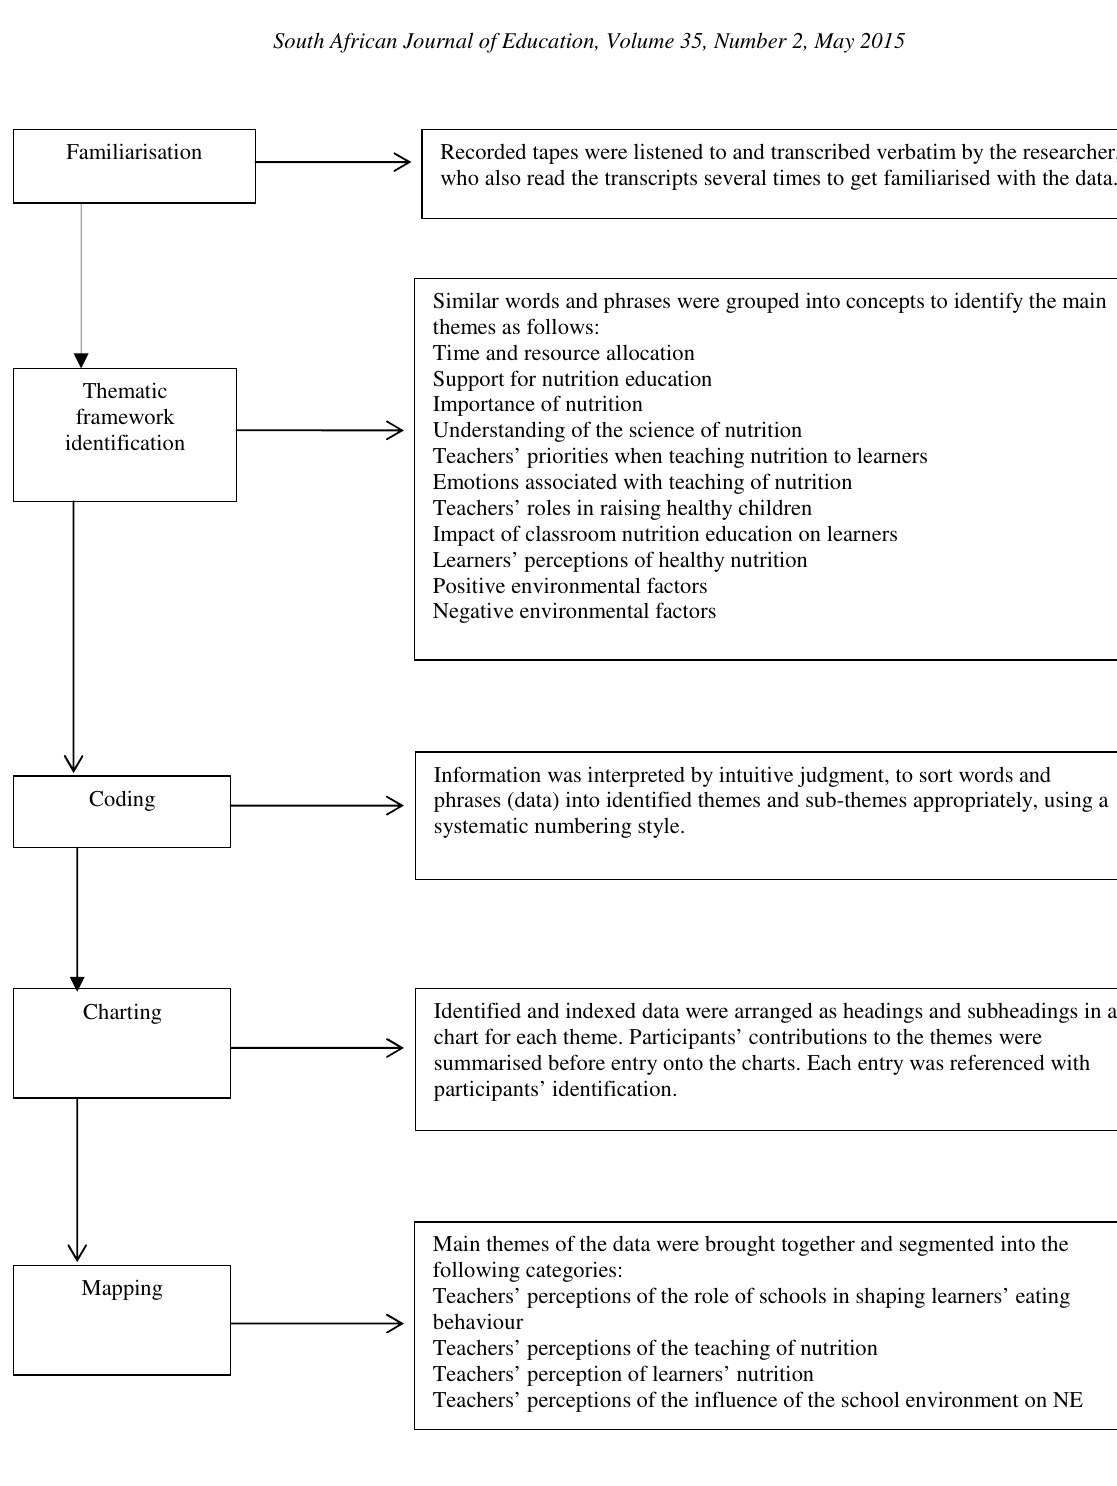
Table 1 Characteristics of Participants (N = 24) Focus group